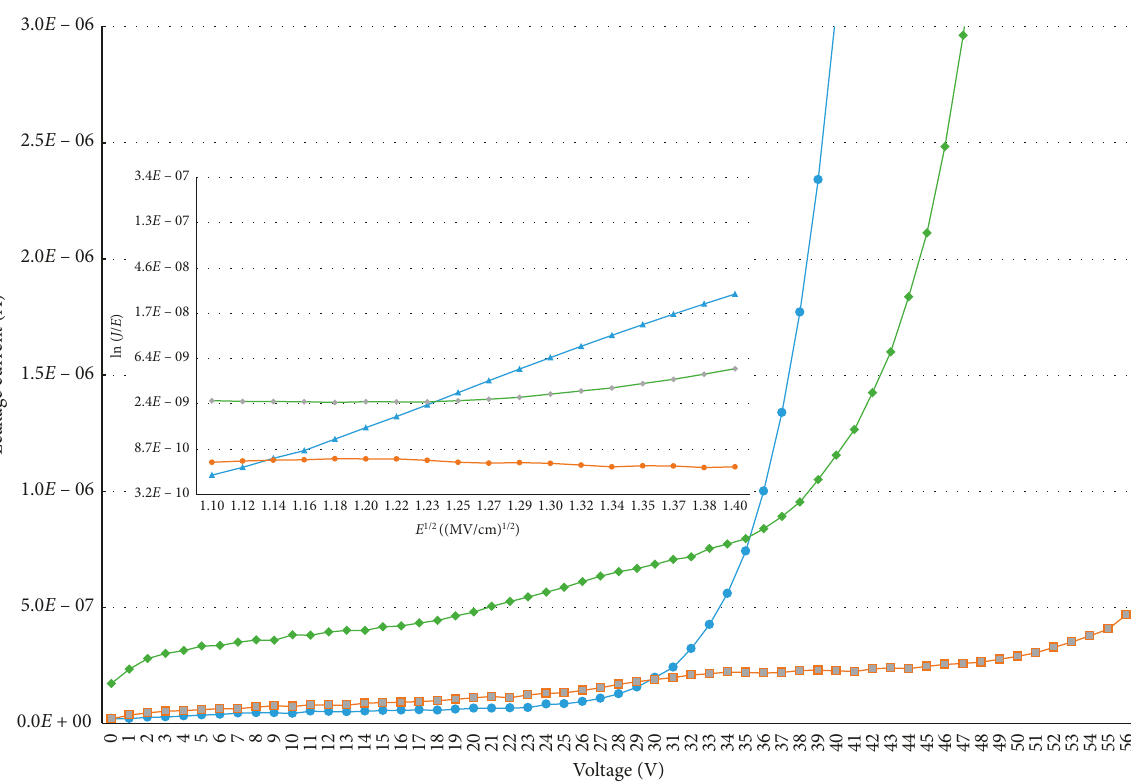
Figure 3: PF emission saturation observed in 35V 22 μ F chip tantalum capacitors. The I - V curve at − 65 ° C converges with the curve at +25 ° C around 30 V and with the curve at +85 ° C near